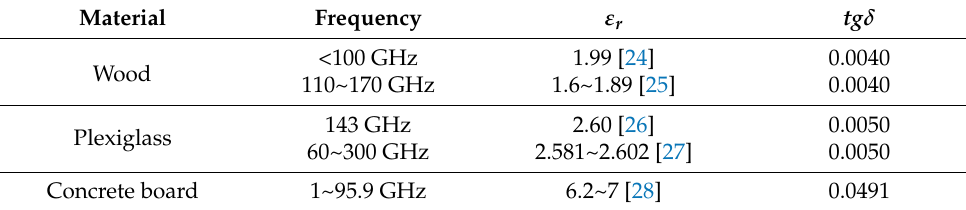
Table 1. Parameters of relative permittivity and tangent loss angle of different